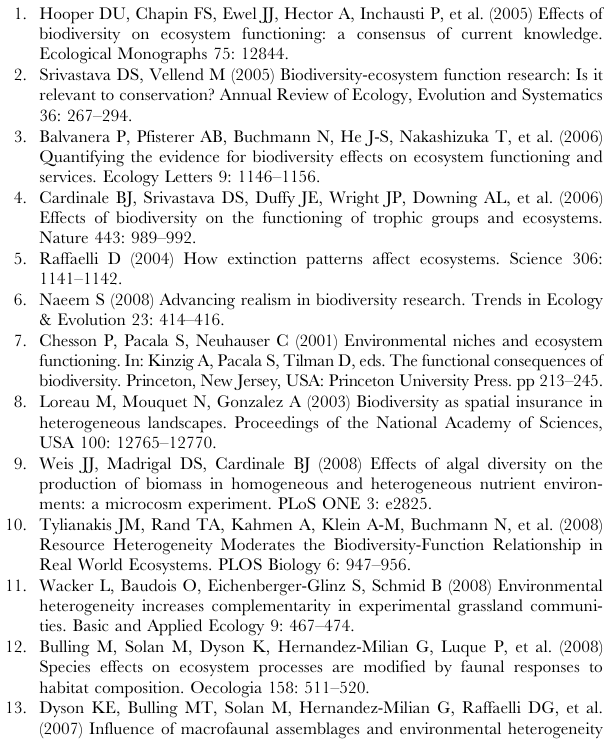
Table S3 Metavariable dissimilarity (distance) matrices and underlying variables.